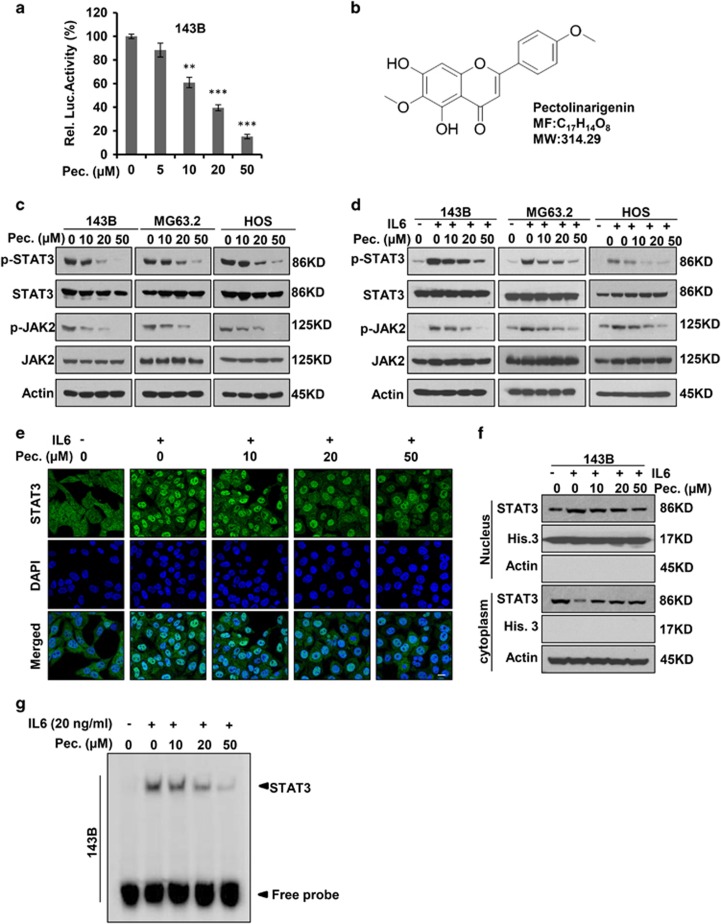
Pectolinarigenin inhibits STAT3 activity in osteosarcoma. (a) 143B cells were transfected with STAT3 luciferase reporter gene plasmid and treated with different concentrations of pectolinarigenin for 24 h. The results were normalized to the Renilla luciferase activity (**P<0.01; ***P<0.001). (b) Chemical structure of pectolinarigenin. (c) A panel of osteosarcoma cell lines was exposed to the indicated concentrations of pectolinarigenin for 24 h. Cells were then lysed and applied to immunoblotting with the indicated antibodies. Actin was used as an internal control. (d) Osteosarcoma cell lines were pretreated with the indicated concentrations of pectolinarigenin for 24 h and then stimulated with IL-6 (20 ng/μl) for 30 min. Whole-cell extracts were prepared and subjected to western blot using the indicated antibodies. (e) 143B cells were seeded on gelatin-coated coverslips and pretreated with pectolinarigenin for 24 h followed by stimulating with IL-6 (20 ng/μl) for 30 min. The coverslips were examined by a confocal microscopy. Anti-STAT3 antibody (green) was used to locate endogenous STAT3. Cell nuclei were stained with 4′, 6-diamidino-2-phenylindole (DAPI). Scale bar, 20 μm. (f) 143B cells were treated with pectolinarigenin for 24 h, and the cytoplasmic and nuclear extractions were subjected to immunoblotting to detect the level of STAT3. (g) 143B cells were pretreated with pectolinarigenin and stimulated with IL-6. An EMSA assay was performed to analyze STAT3 DNA-binding activity